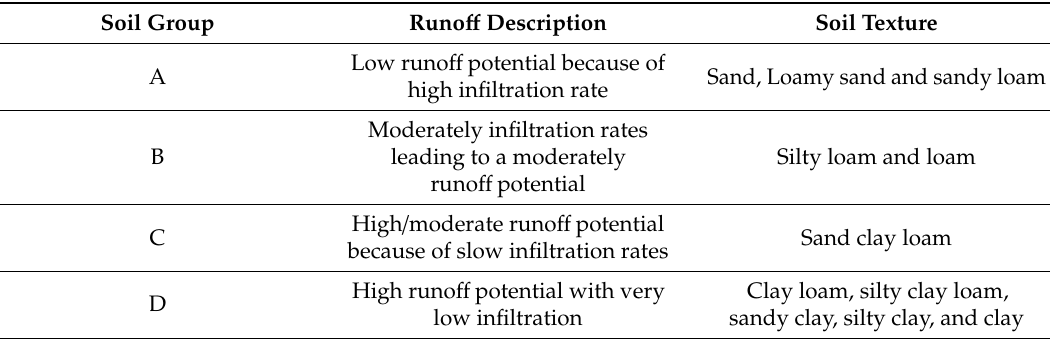
Table 2. Hydrological soil groups and corresponding soil textures from [39].